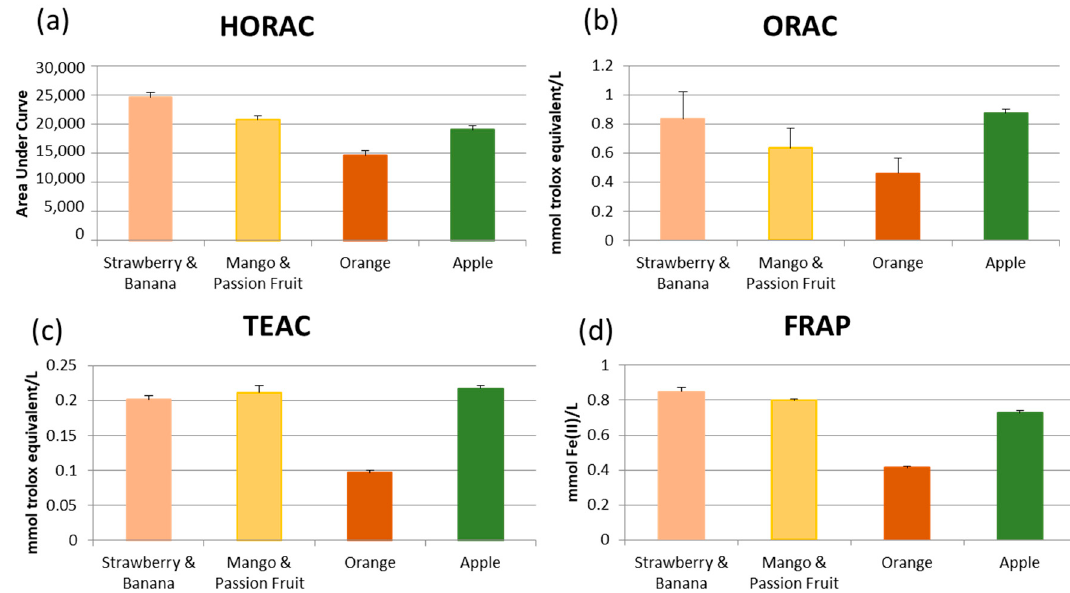
Figure 1. Antioxidant activity of juice/smoothie samples measured by four independent methods; ferric reducing ability of plasma (FRAP), the trolox equivalent antioxidant capacity (TEAC), oxygen radical absorbance capacity (ORAC) and the hydroxyl radical antioxidant capacity (HORAC). Data is presented as mean ± standard deviation (n = 3). All comparisons were significantly different ( p < 0.05) with the exception of the ORAC data for strawberry and banana smoothie compared to apple juice.